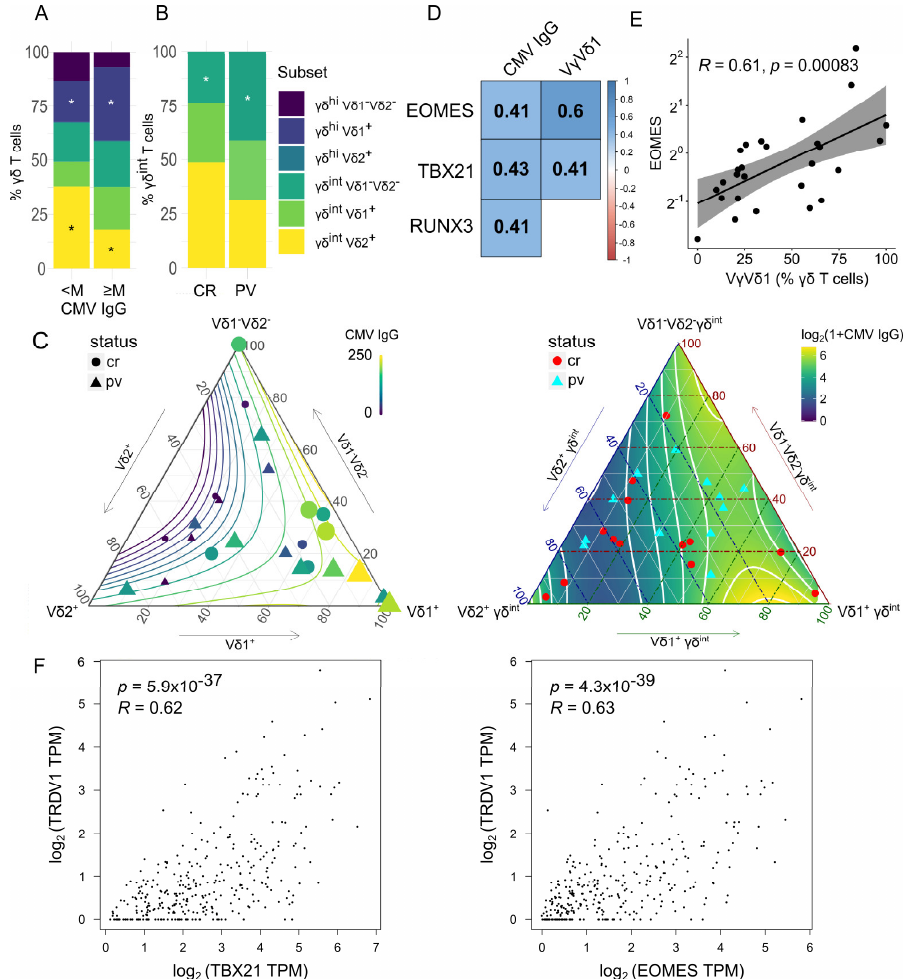
Figure 1. Stacked barplots (average percentage) showing the γδ blood T-cell composition by ( A ) cytomegalovirus (M corresponds to median serum CMV IgG, 132 IU/mL, panel A, 12 + 12 donors) and ( B ) case (PV, n = 13)–control (CR, n = 14) status. An asterisk denotes a statistically significant difference according to the two-tailed Mann–Whitney test, * p < 0.05. Only significant differences are plotted. ( C ) The distribution of γδ T-cell subsets in ternary coordinates. The three coordinates add to a constant of 100%. The color-coded isocontour lines of serum CMV IgG levels have been smoothened to filter out local features. Left panel: The color and size of the points are determined by the value of the serum CMV IgG (color bar). Right: The background shows color-coded CMV IgG levels. ( D ) Gene expression associations with the γδ blood T-cell composition and serum IgG levels. The colored scale bar reports Spearman rank correlations (R). All correlations are significant at p < 0.05. ( E ) Scatter plot representing a relation between the EOMES gene expression in bulk γδ blood T cells and their composition (Vδ1 + fraction, flow cytometry). R denotes the Spearman’s correlation coefficient; each dot represents one donor. The black line represents a linear model fit (least squares method), whereas the shaded region indicates the 95% confidence interval. The Y-axis (fold change) is log-scaled. ( F ) Expression levels of the TRDV1 , EOMES, and TBX21 genes in the whole blood samples [ n = 337, log-transformed (1 + TPM) values, GTEx project, USCS Xena, gepia2.cancer-pku.cn]. Each dot represents one donor. Numbers denote Spearman’s correlation coefficients and their p -values. TPM transcript per million.